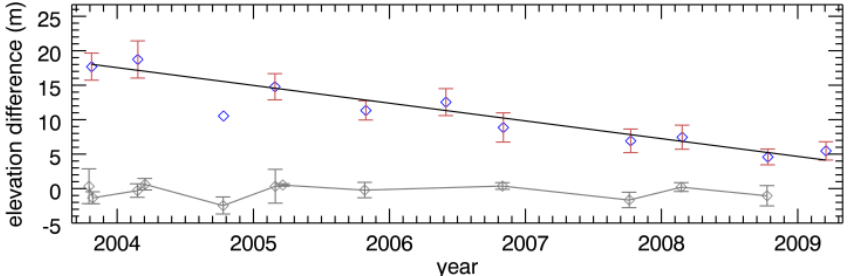
Figure 6. Linear trend of the surface lowering in area A2 fitted through multi-seasonal ICESat data using the Airphoto DEM as elevation reference. A terrain slope threshold of 10° and snow pack corrections were applied. Values of mean ΔH for off-glacier area (in grey) do not show a statistically significant trend.